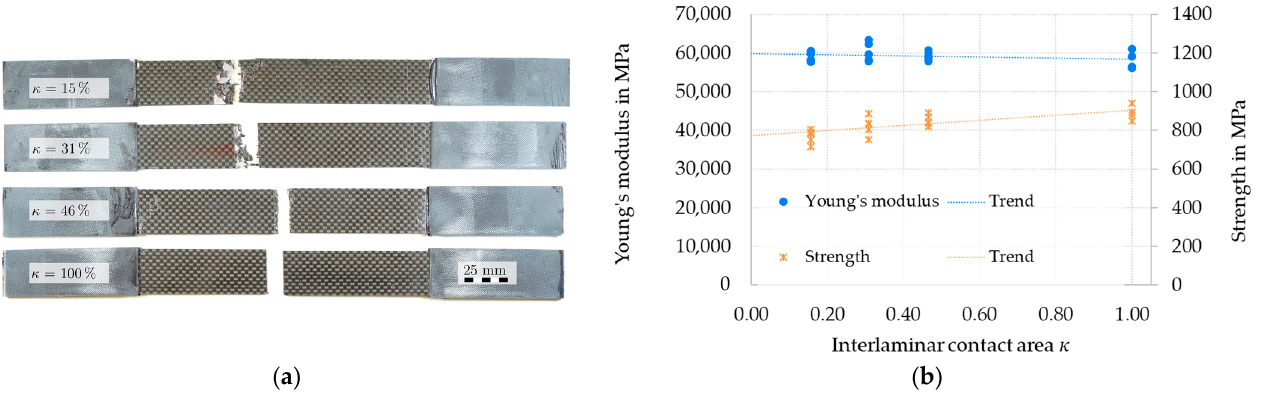
Figure 2. Failure behaviour of interface-modified textile-reinforced CFRP; ( a ) tensile specimens after tests and ( b ) corresponding mechanical in-plane properties in weft direction.